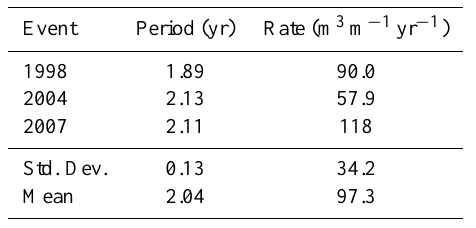
Table 2. Event grouped ensemble average recovery period and rate for the major erosion events.